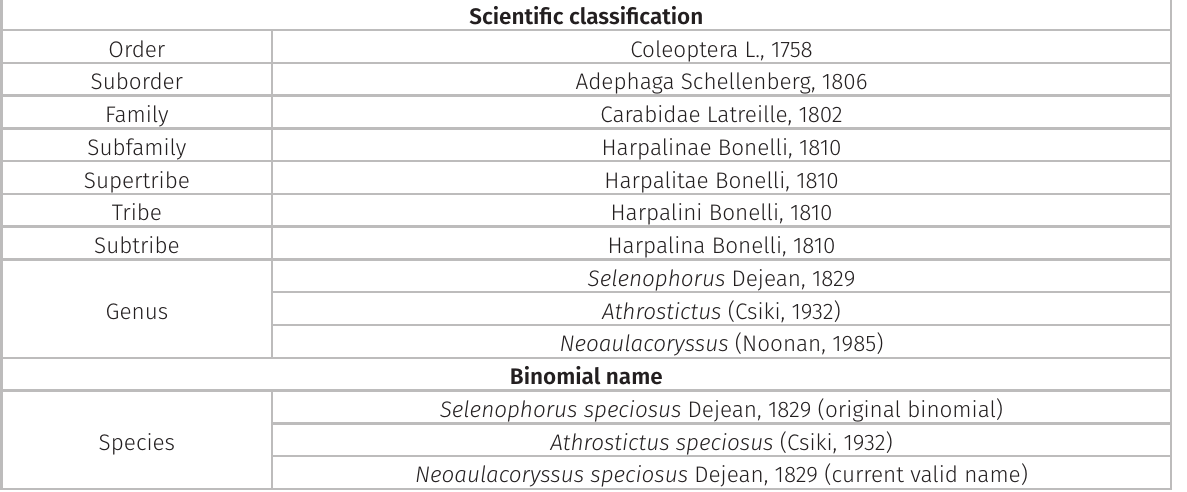
Table II. Scientific classification of Neoaulacoryssus